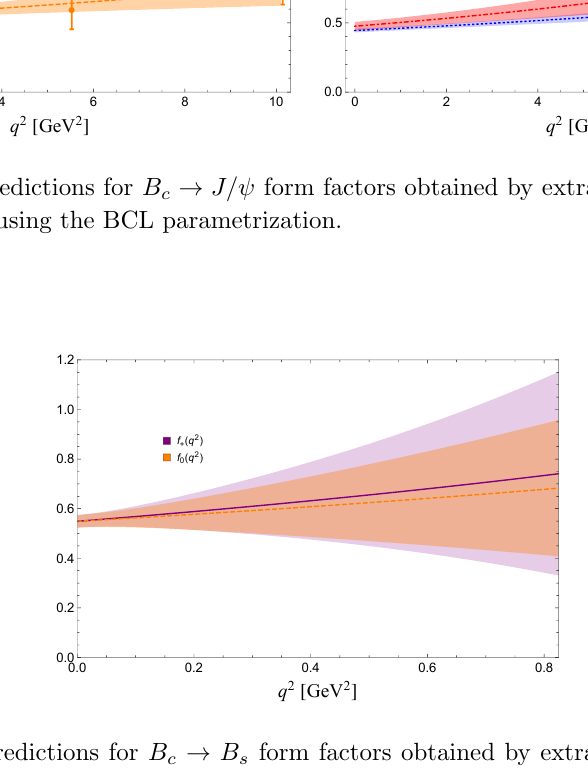
Figure 13 . Final predictions for B c ! B s form factors obtained by extrapolating 3ptSR results to higher q 2 regions using the BCL parametrization.